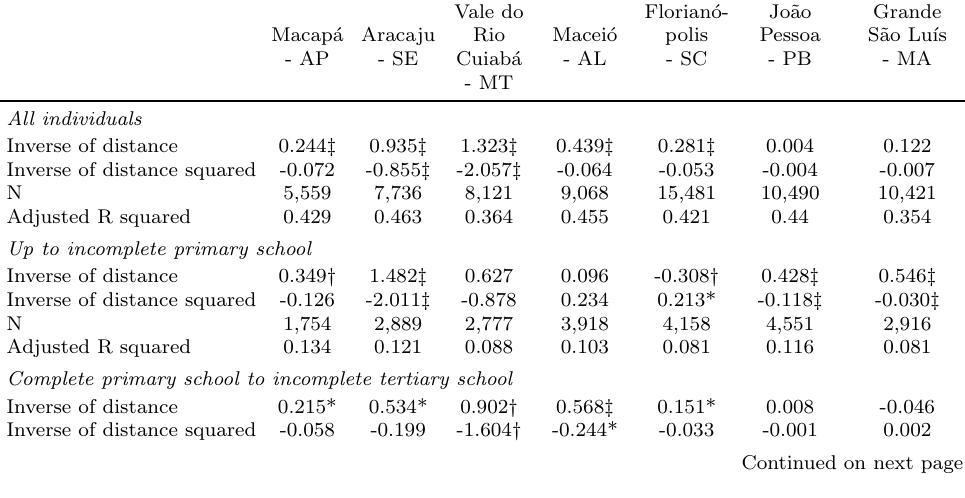
Table 4: OLS regressions of the logarithm of the hourly wage, for all individuals and by education